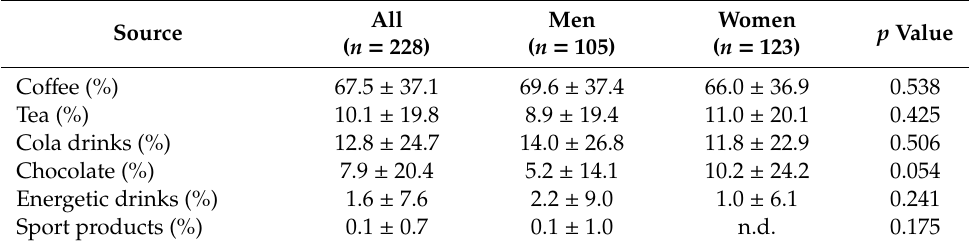
Table 2. Sources of ca ff eine intake among those participants consuming ca ff